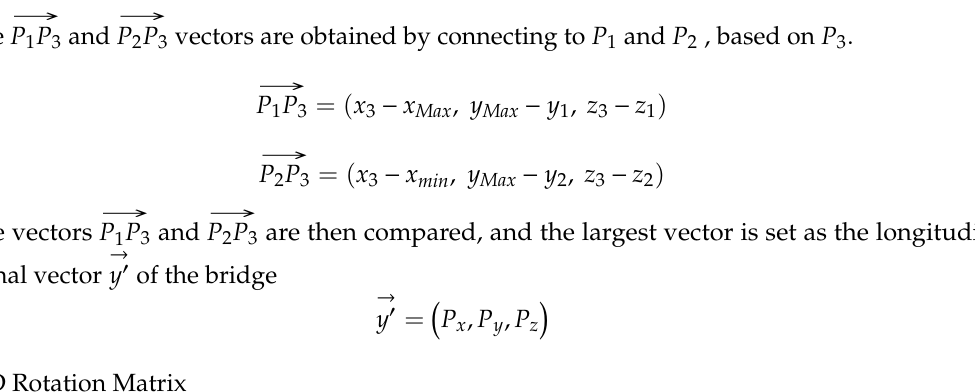
Figure 6. Reference vector